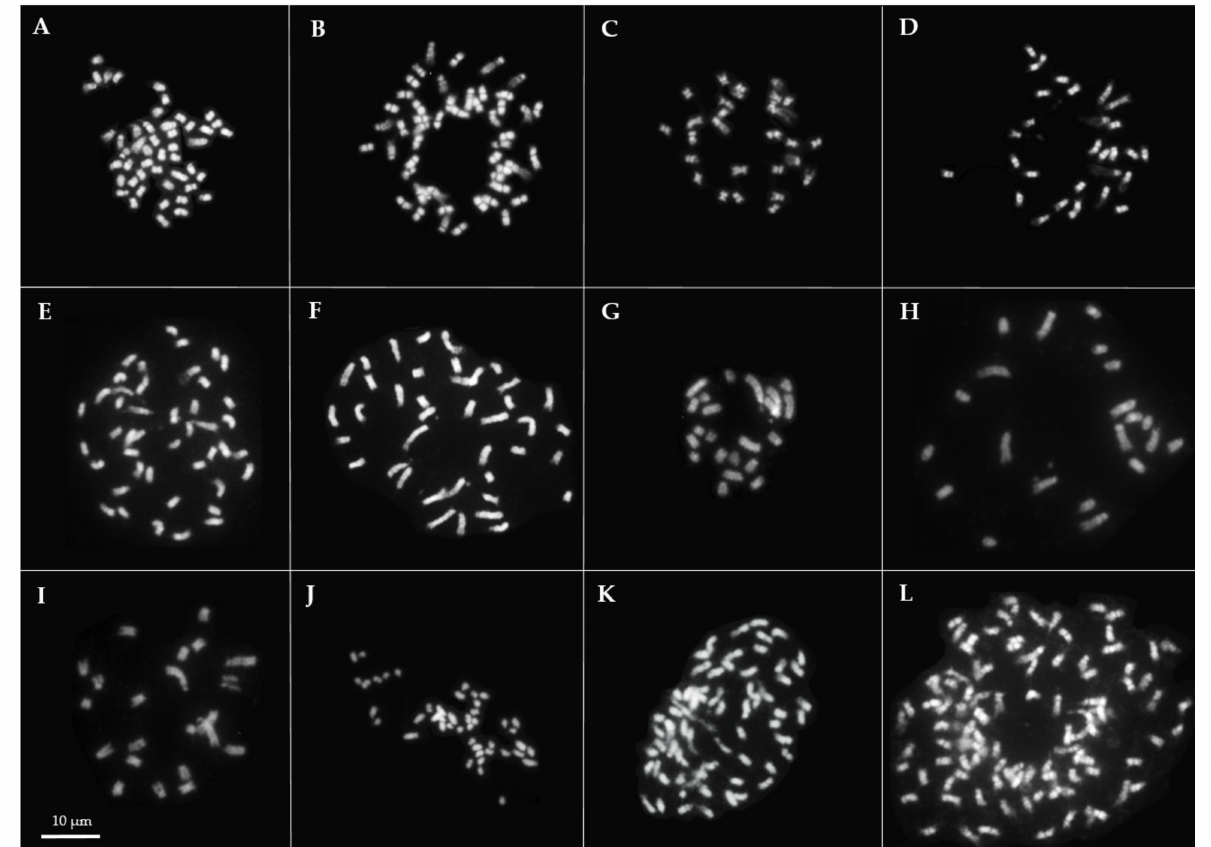
Figure 3. Chromosome counts of Lavandula genotypes: L. angustifolia ‘Hidcote’ (L57), 2n = 48 ( A ); L. lanata (L108), 2n = 50 ( B ); L . stoechas ‘Otto Quast’ (L28), 2n = 28 ( C ); L. pedunculata ‘Papillon’ (L15), 2n = 30 ( D ); L. dentata (L4), 2n = 44 ( E ); L. pubescens (L99), 2n = 40 ( F ); L. canariensis (L94), 2n = 22 ( G ); L. rotundifolia (L121), 2n = 22 ( H ); L. multifida (L126), 2n = 22 ( I ); L. antineae (L118), 2n = 44 ( J ); L . × heterophylla ‘Big Boy James’ (L13), 2n = 66 ( K ); L . × intermedia ‘Heavenly Angel’ (L30), 2n = 100 ( L ). Scale bar = 10 µ